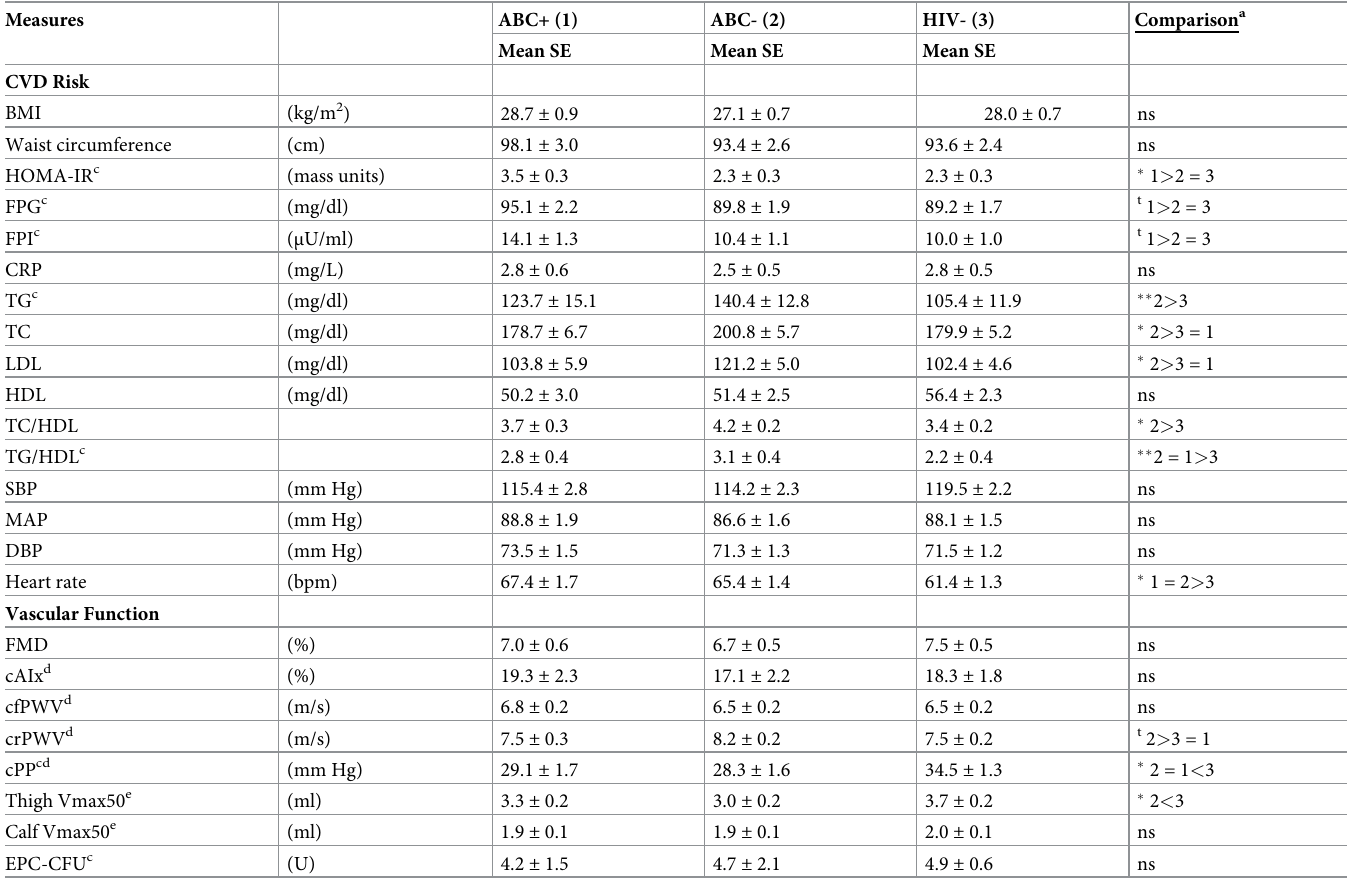
Table 4. Subclinical cardiometabolic measures comparing study groups when controlling for demographic variables (sex, age, education).